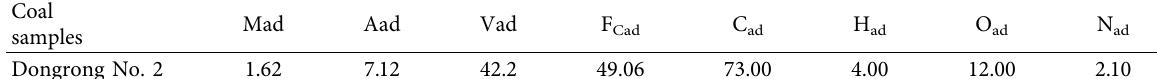
Table 1: Experimental results of the coal industry and elements.